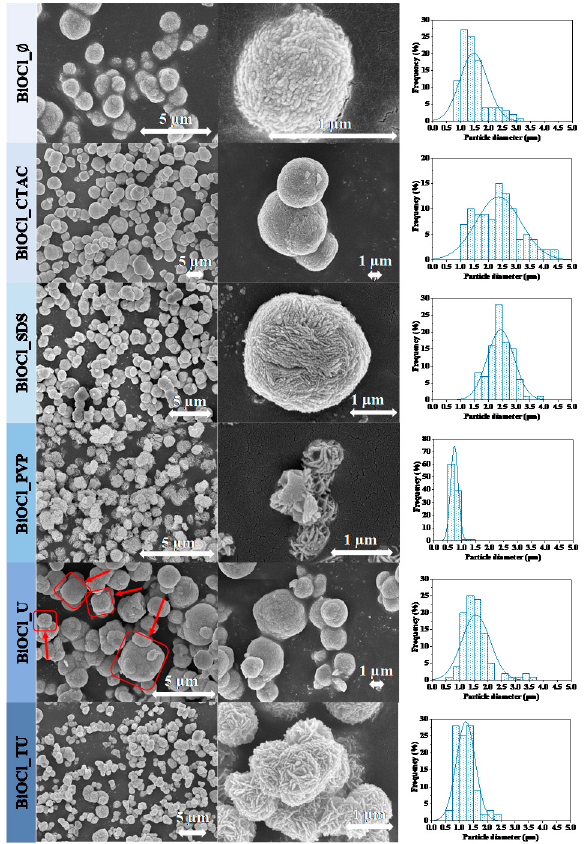
Figure 2. The SEM micrographs of the obtained BiOCl catalyst materials using different additives.